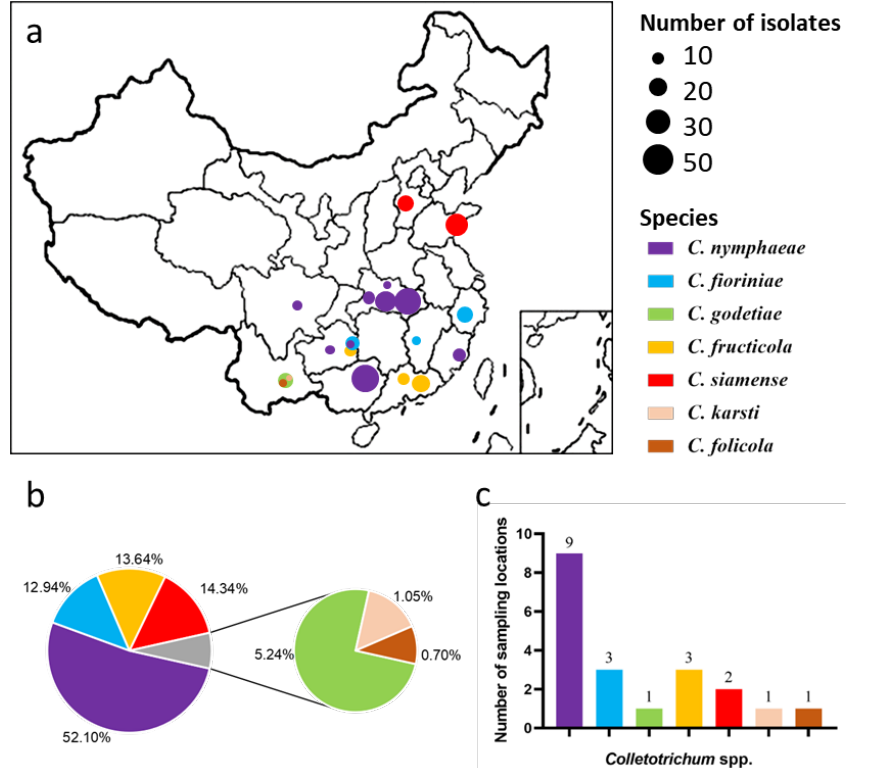
Figure 2. Prevalence of Colletotrichum spp. associated with peaches in China. ( a ) Map of the distribution of Colletotrichum spp. on peaches in China. Each color represents one Colletotrichum species, and the size of the circle indicates the number of isolates collected from that location. ( b ) Overall isolation rate (%) of Colletotrichum species; ( c ) number of sampling locations for each Colletotrichum species.